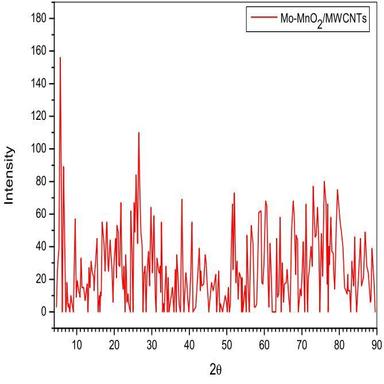
XRD pattern of mesoporous (Mo–MnO2/MWCNT).